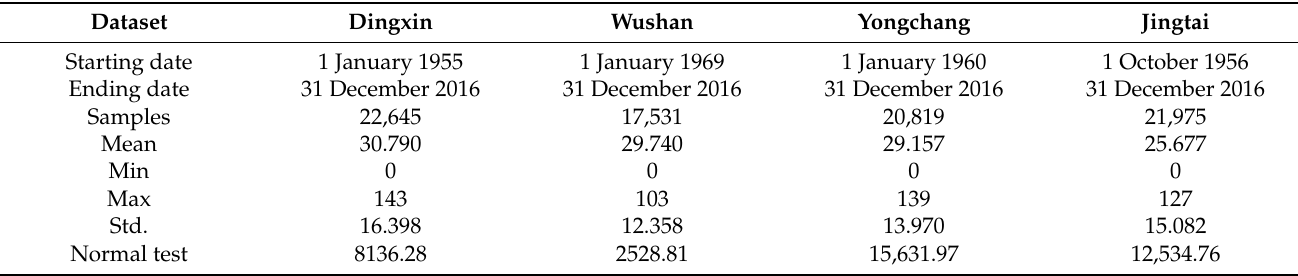
Table 2. The basic information of